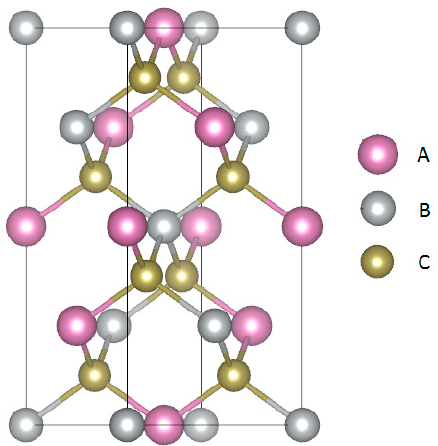
Figure 1. Crystal structure of the A I B III C 2VI chalcopyrite compounds.